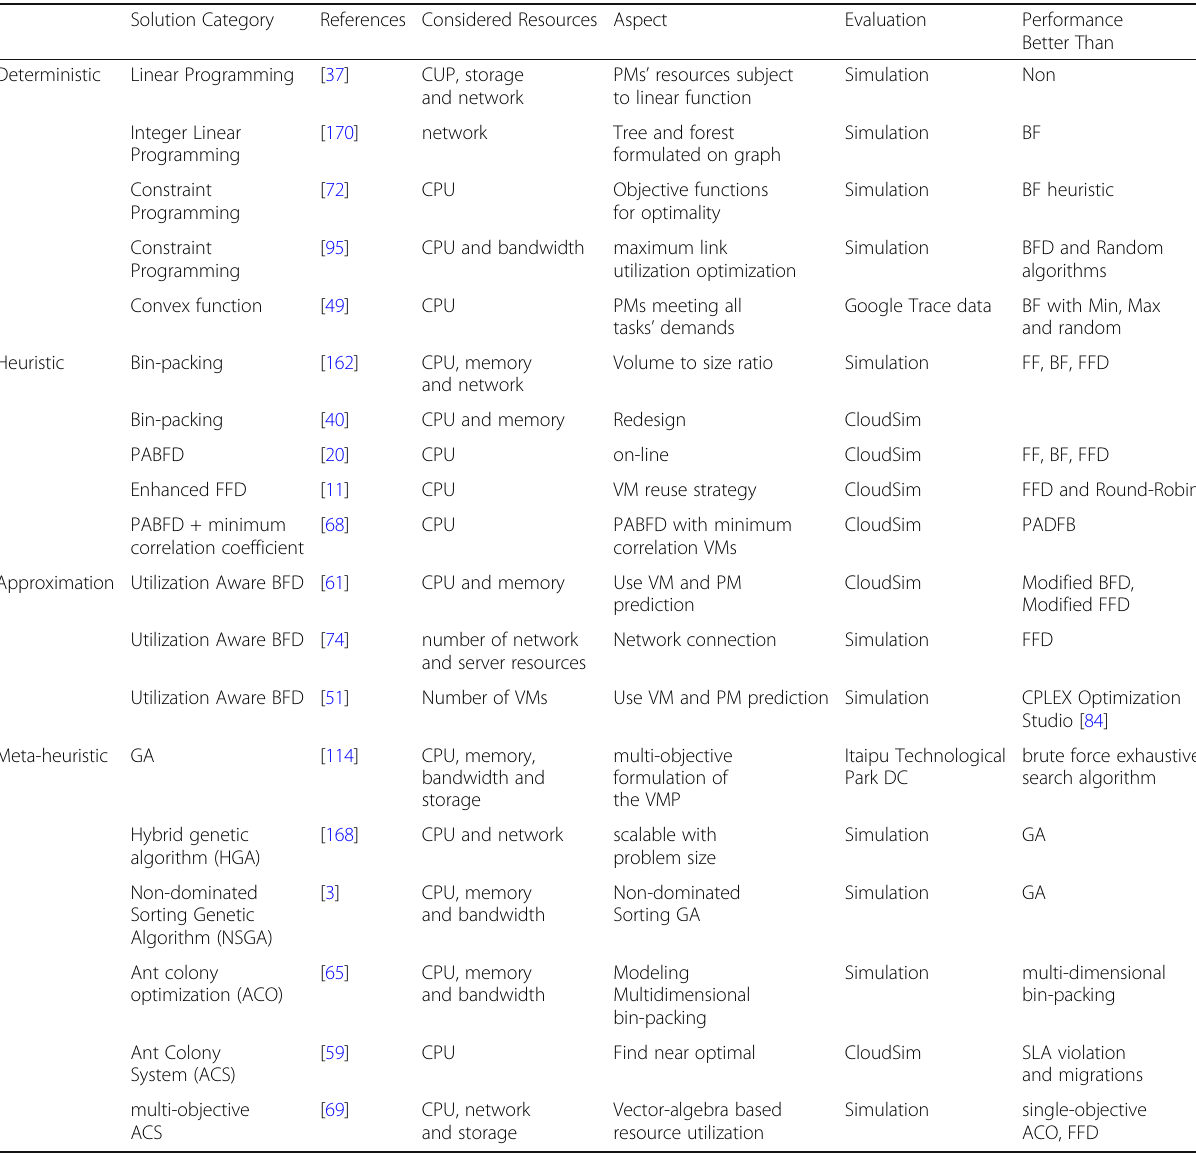
Table 4 VMP algorithms based solution techniques Solution